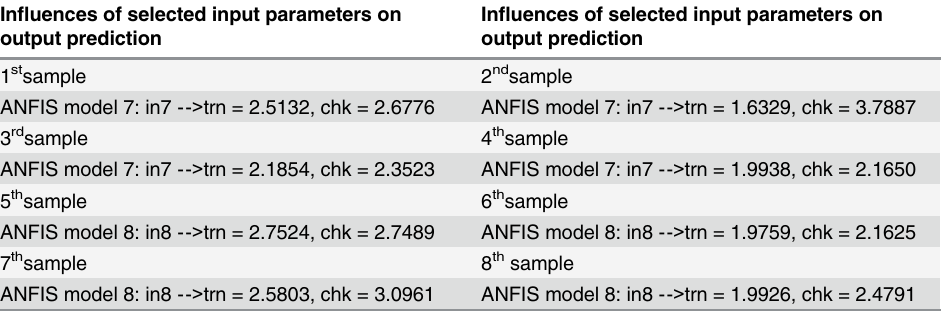
Table 4. Every input parameter ’ s influence on vehicle agent speed relative to vehicle intruder prediction. In fl uences of selected input parameters on output prediction